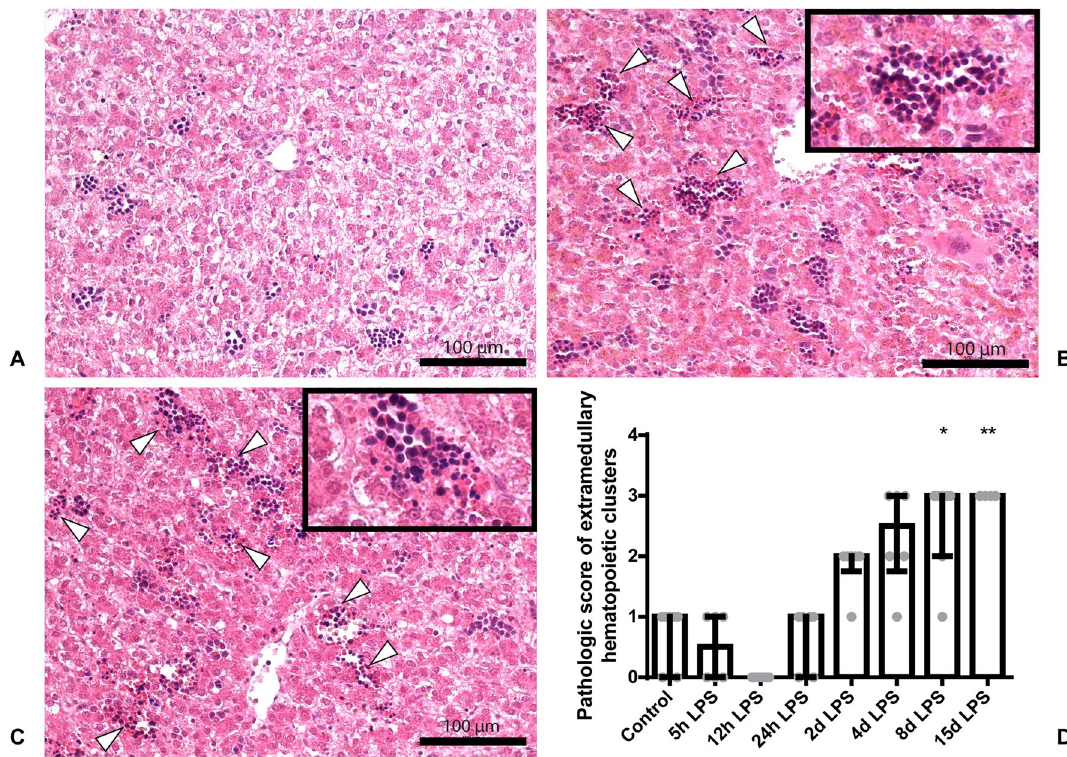
Figure 2. Scoring of H&E slides on a 0 to 4 scale for degree of sinusoidal dilatation, shape and size of central veins and number and location of extramedullary hematopoietic clusters. Representative images of control ( A ), at day 8 after IA LPS administration ( B ) and at day 15 after LPS administration ( C ). Data are presented as median with IQR ( D ). D: Pathologic score with increased number of extramedullary hematopoietic clusters in the animals at day 8 and day 15 after IA LPS administration. Specifically, the increased extramedullary hematopoiesis, which manifests as clustering and conflation of hepatic erythropoiesis in the parenchyma, is indicated by white triangles (b + c). * P < 0.05 and ** P < 0.01 compared to control.